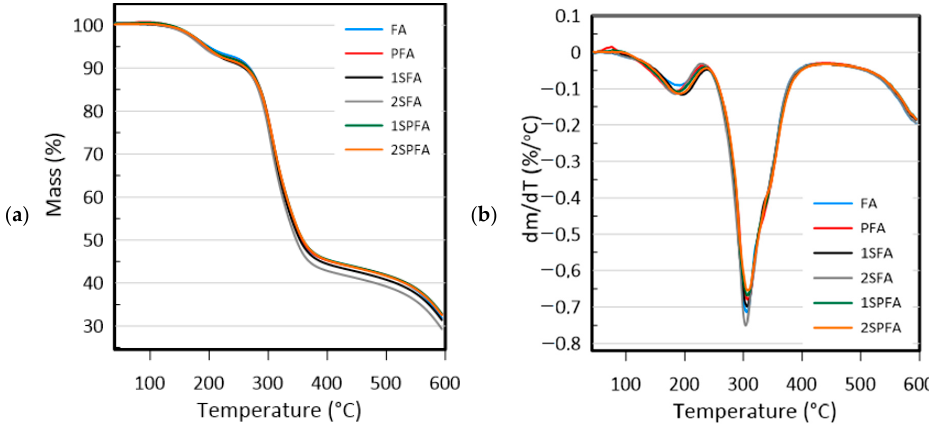
Figure 8. TG ( a ) and DTG ( b ) curves of PUR composites.